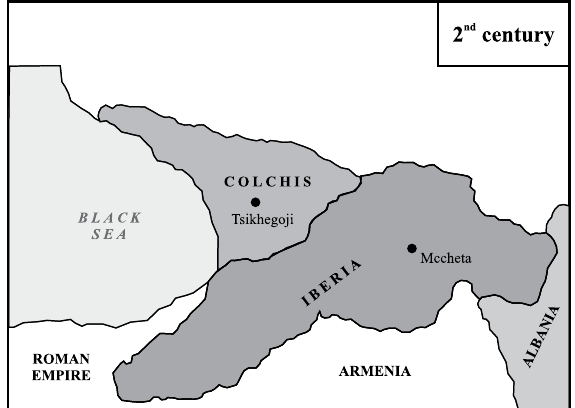
Fig. 1. Stage 1: establishment of the first historical regions of